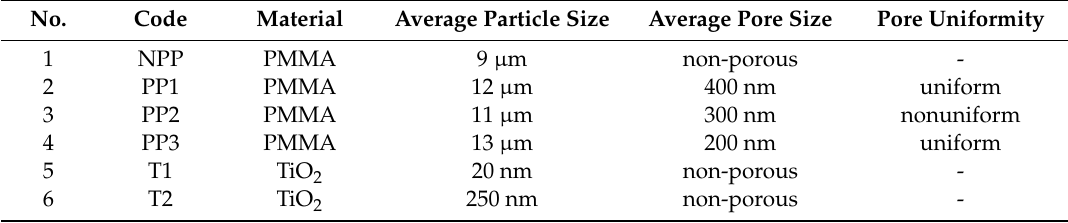
Table 1. Characteristics of PMMA microparticles and TiO 2